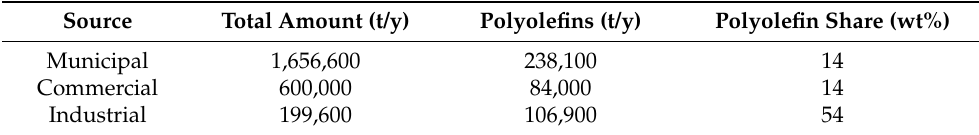
Table 7. Available post-consumer polyolefins in Austria in 2015 [6].